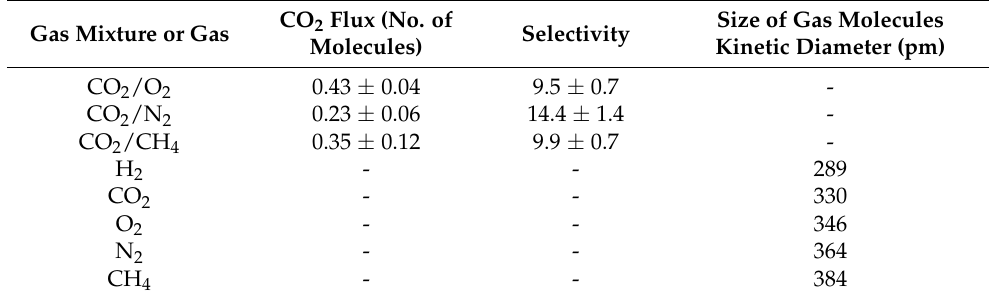
Figure 3. Configuration of CO 2 molecule in graphene pore [90]. Reproduced with permission from Elsevier. Table 1. Separation of CO 2 from different gas mixtures using graphene membrane [90]. Reproduced with permission from Elsevier.